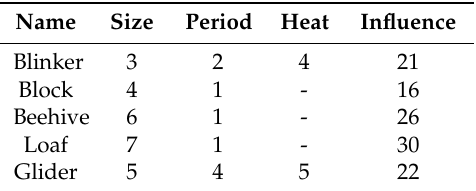
Table 1. The most common clusters found in the GoL. Columns: Name of object, Size (number of live cells per object), Period (0 means no period exists), Heat (number of changing cells), Influence area (all cells which are in the Moore-neighborhood of each live cell of an